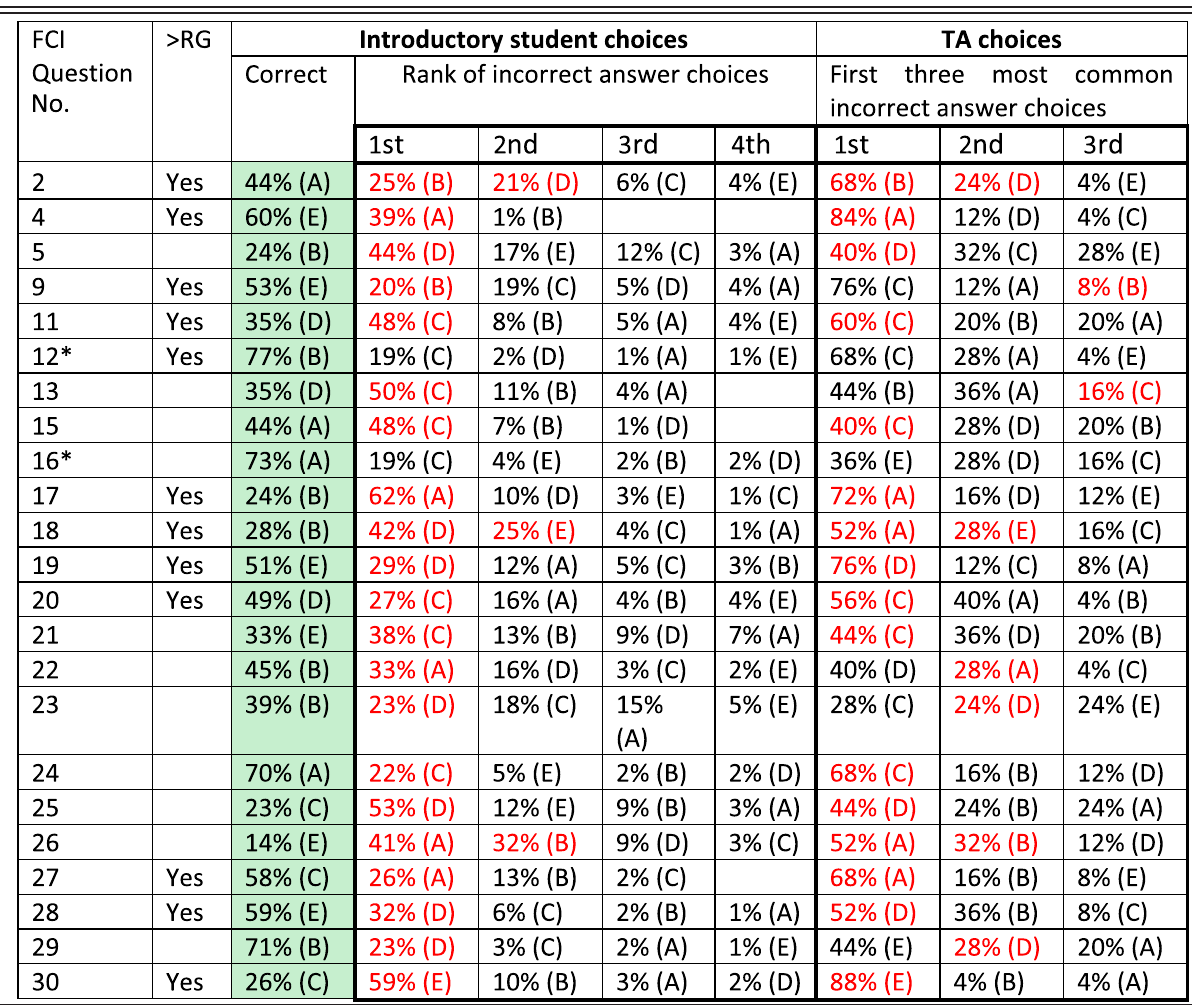
TABLE I. Questions on the FCI on which at least 20% of introductory algebra-based students selected one incorrect answer choice in a post-test (questions 12 and 16 marked with an * had 19% of students selecting one answer choice, but they are included here because on these questions many TAs selected incorrect answer choices as most common among introductory students, but very few introductory students selected those answer choices), percentages of introductory algebra-based physics students who answered the questions correctly in a post-test, percentages of introductory students who selected each incorrect answer choice ranked from most to least common (they were asked to select the correct answer for each question), the three most common incorrect answer choices selected by TAs (they were asked to select the most common incorrect answer for each question if introductory physics students did not know the correct answer). The first column of the table lists the FCI question numbers and the second column titled “ > RG ” shows a “ Yes ” when the TAs on average performed better than random guessing (RG). Note that answer choices marked in red (e.g., 25% (B) for question 2) indicate that 20% or more introductory students selected that answer choice. The same answer choices are also colored in the case of the TAs to make them stand out (i.e., one should not expect that for the TAs, the red coloring is used for the questions selected by 20% or more of the TAs — the introductory student percentages determine the